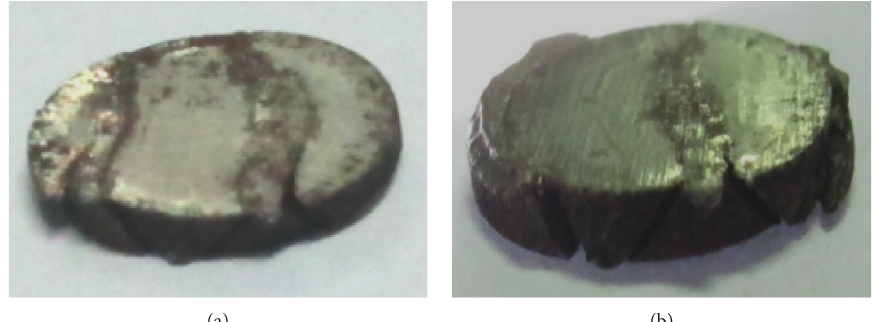
Figure 14: Recycled specimens for dynamic compression experiments at varying temperature. (a) QP980 steel RSW; (b) TRIP800 steel